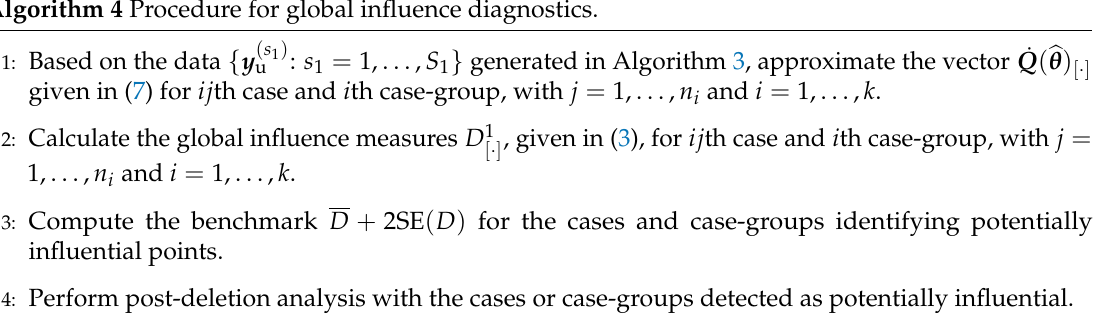
Algorithm 4 Procedure for global influence diagnostics.